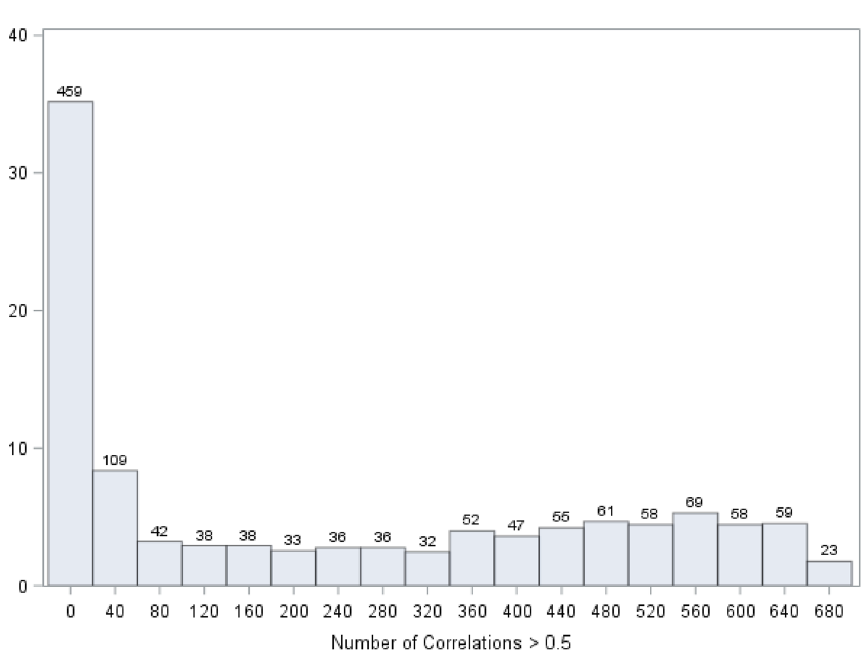
Figure 4. Distribution of the number of proteins that correlate with other proteins at the Spearman correlation coefficient of 0.5 or above. The purpose of this correlation analysis is to identify proteins that are least correlated to other proteins. For example, in the first bar of this graph, there are 459 proteins that are correlated at 0.5 or above with 0 to 20 other proteins. There are 23 proteins that are highly correlated (0.5 or above) with 660 to 700 other